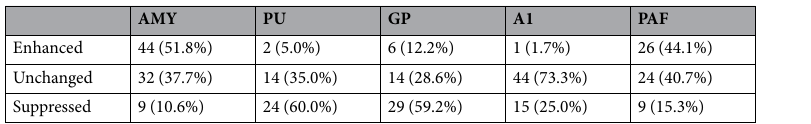
Table 1. Number (percentage) of different types of units in different brain